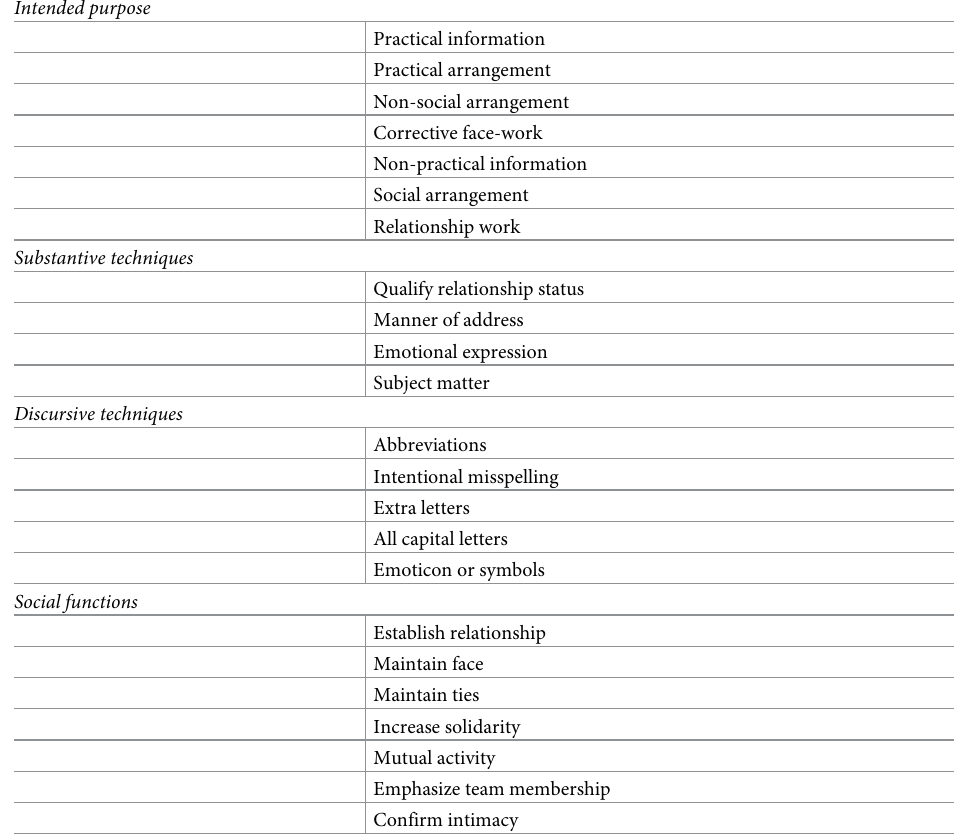
Table 2. Overview of communication properties and major